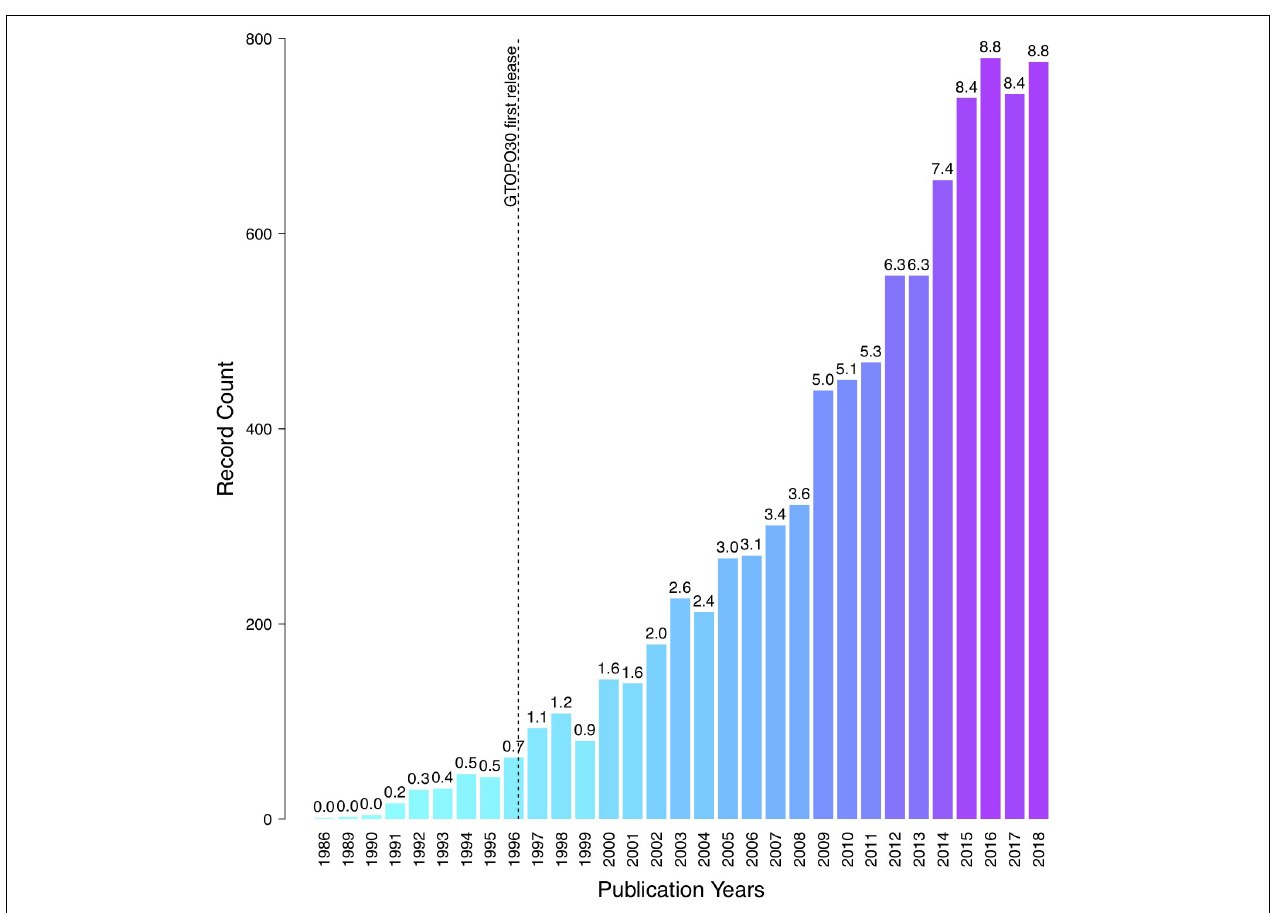
FIGURE 1 | Number of scientific publications mentioning the words “digital elevation model.” Values on top of bars correspond to percentage of total records (data source: Web of Science, Clarivate Analytics, 2018).